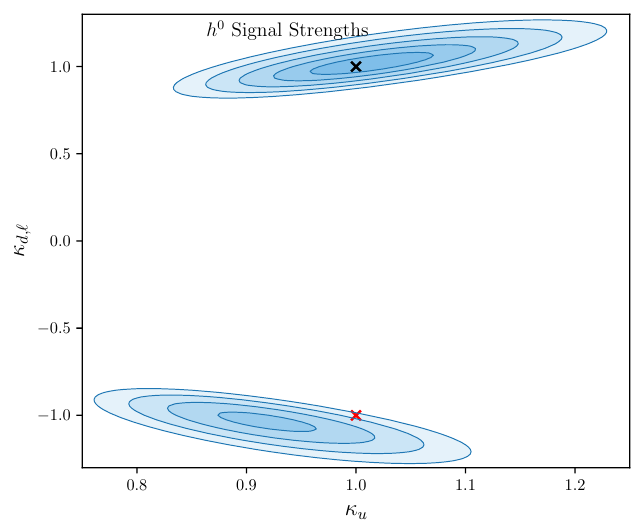
Figure 3. Contour plot of the coupling constant modifiers, in which we have fixed to its best fit value κ V = 1 . 036 and marked the alignment (wrong-sign) limit in black (red). The contours indicate the allowed space at 1, 2, 3, 4, 5 σ from dark to